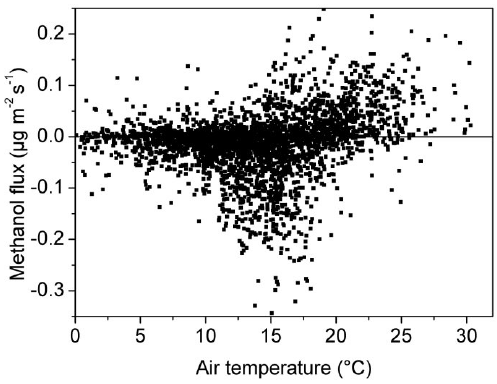
August-September